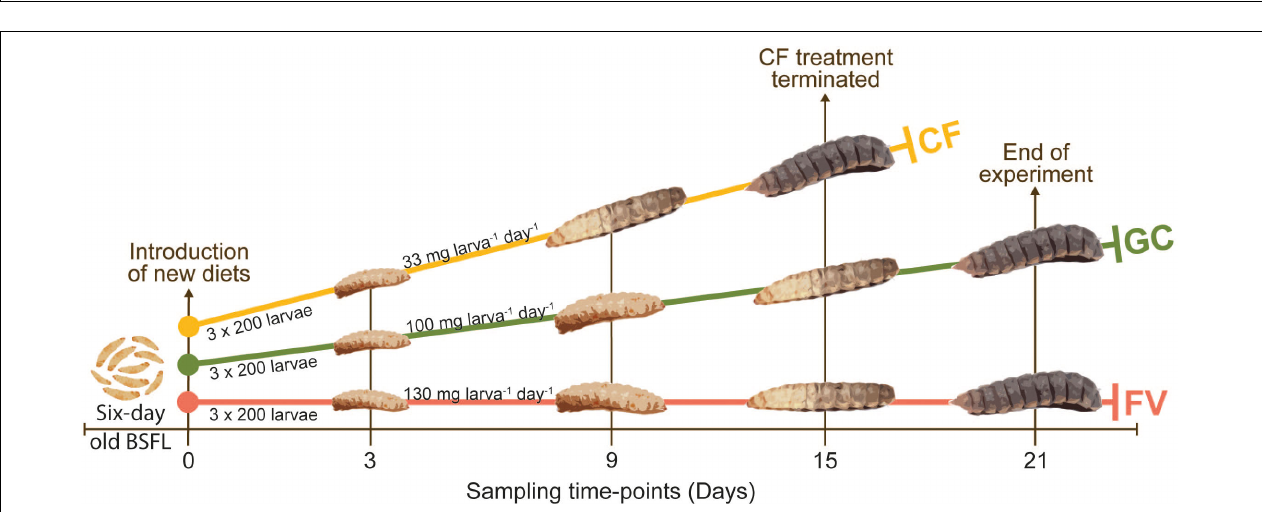
FIGURE 2 | Relative abundance of bacterial classes in diets used as treatments ( n = 3). OTUs with a relative abundance lower than 1% were summarized. Note that the significance of differences between sample groups was tested at fine scale delinetation, i.e., the level of genus and 97% OTUs. The community composition on class level is shown for simplicity instead of a more detailed scale.